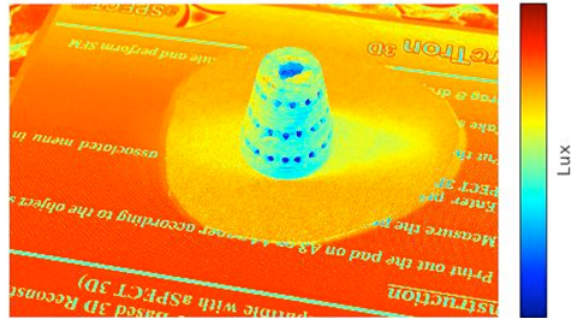
Figure 5. False color image of the Amber Object luminance values for HDR image